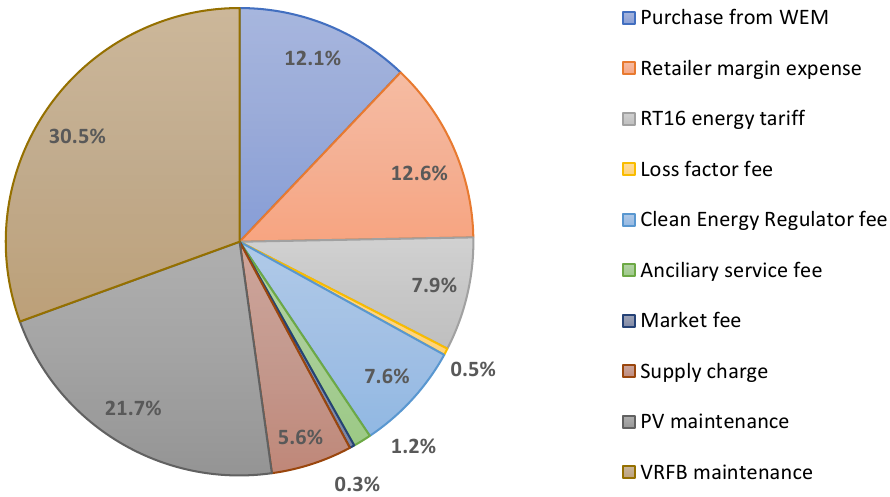
Figure 10. The breakdown of net present value (NPV) revenue (AUD) over 20 years for the VPP in the cases I to IV, defined at the beginning of this section.